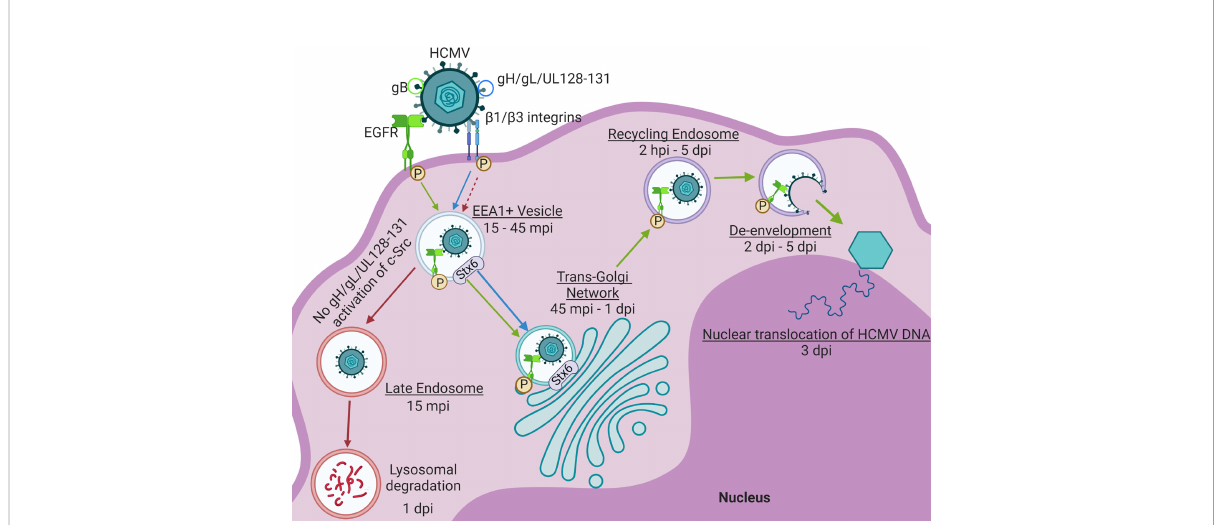
FIGURE 4 HCMV drives distinct Nuclear Translocation in Primary Human Monocytes. HCMV glycoproteins gB and the pentamer complex (gH/gL/UL128- 131) engage and activate EGFR and b 1/ b 3 integrins, respectively. Viral activation of these signaling cascades facilitate the internalization of the viral particle. After internalization, the virus is traf fi cked to EEA1+ vesicles along with phosphorylated EGFR (p-EGFR) (15 – 45 mpi) (79, 83). Lack of pentamer-activated signaling alternatively results in the sorting of virus to late endosomes and subsequently, viral degradation within 24 hpi. From the EEA1+ vesicle, both HCMV and p-EGFR traf fi c to the TGN (45 mpi – 1 dpi). The virus and p-EGFR are then subsequently taken to Rab11+ recycling endosomes (2 hpi – 5 dpi) where de-envelopment occurs approximately 2 – 5 dpi. Viral and p-EGFR transport to both the TGN and recycling endosome are regulated by Syntaxin 6 (Stx6) (14). After de-envelopment, the genome-containing capsid is free to dock at the nucleus and inject the HCMV genome beginning around 3 dpi (79, 83). Made with